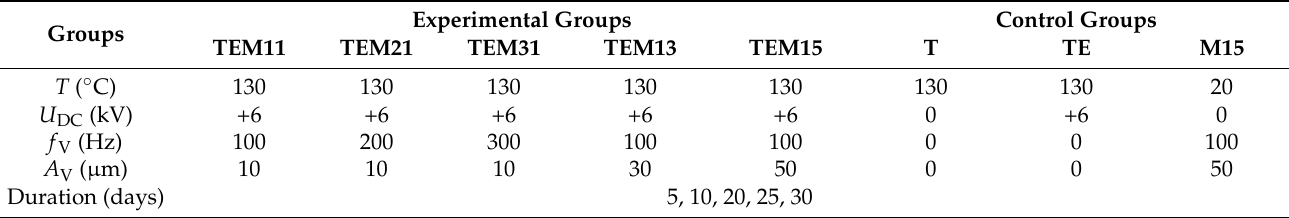
Table 1. OIP multi-stress aging experimental parameters.